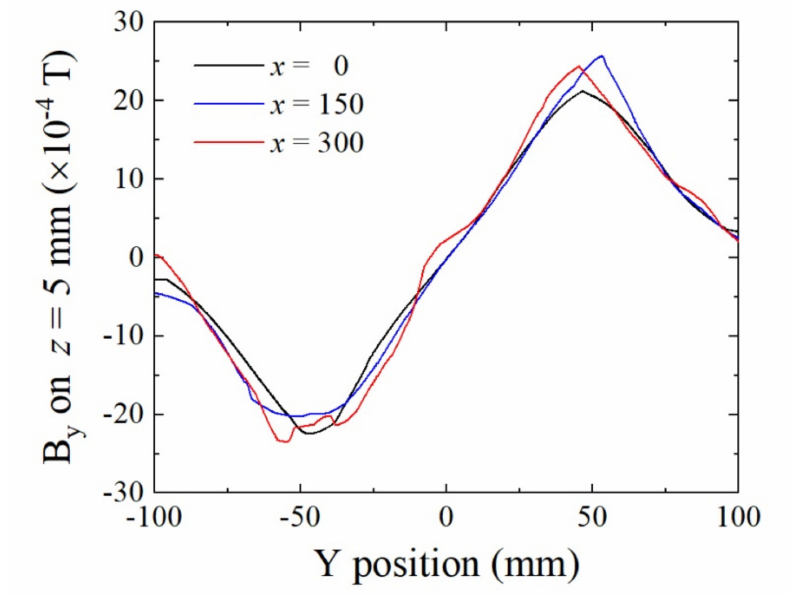
Figure 12. Simulated variations in magnetic flux density B y on Y-position at the sensor height z = 5 mm as a parameter of transverse position X. (Unit of x : mm).